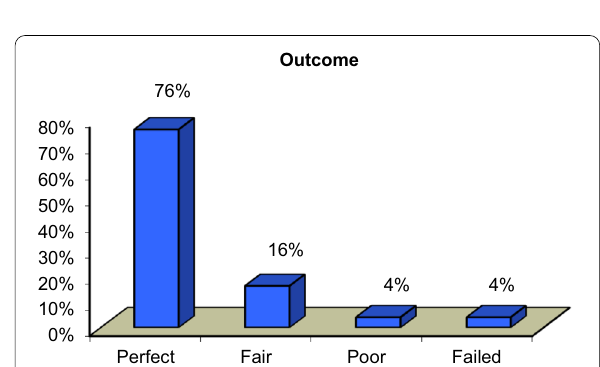
Fig. 6 The percentage of procedures early outcome of our cases